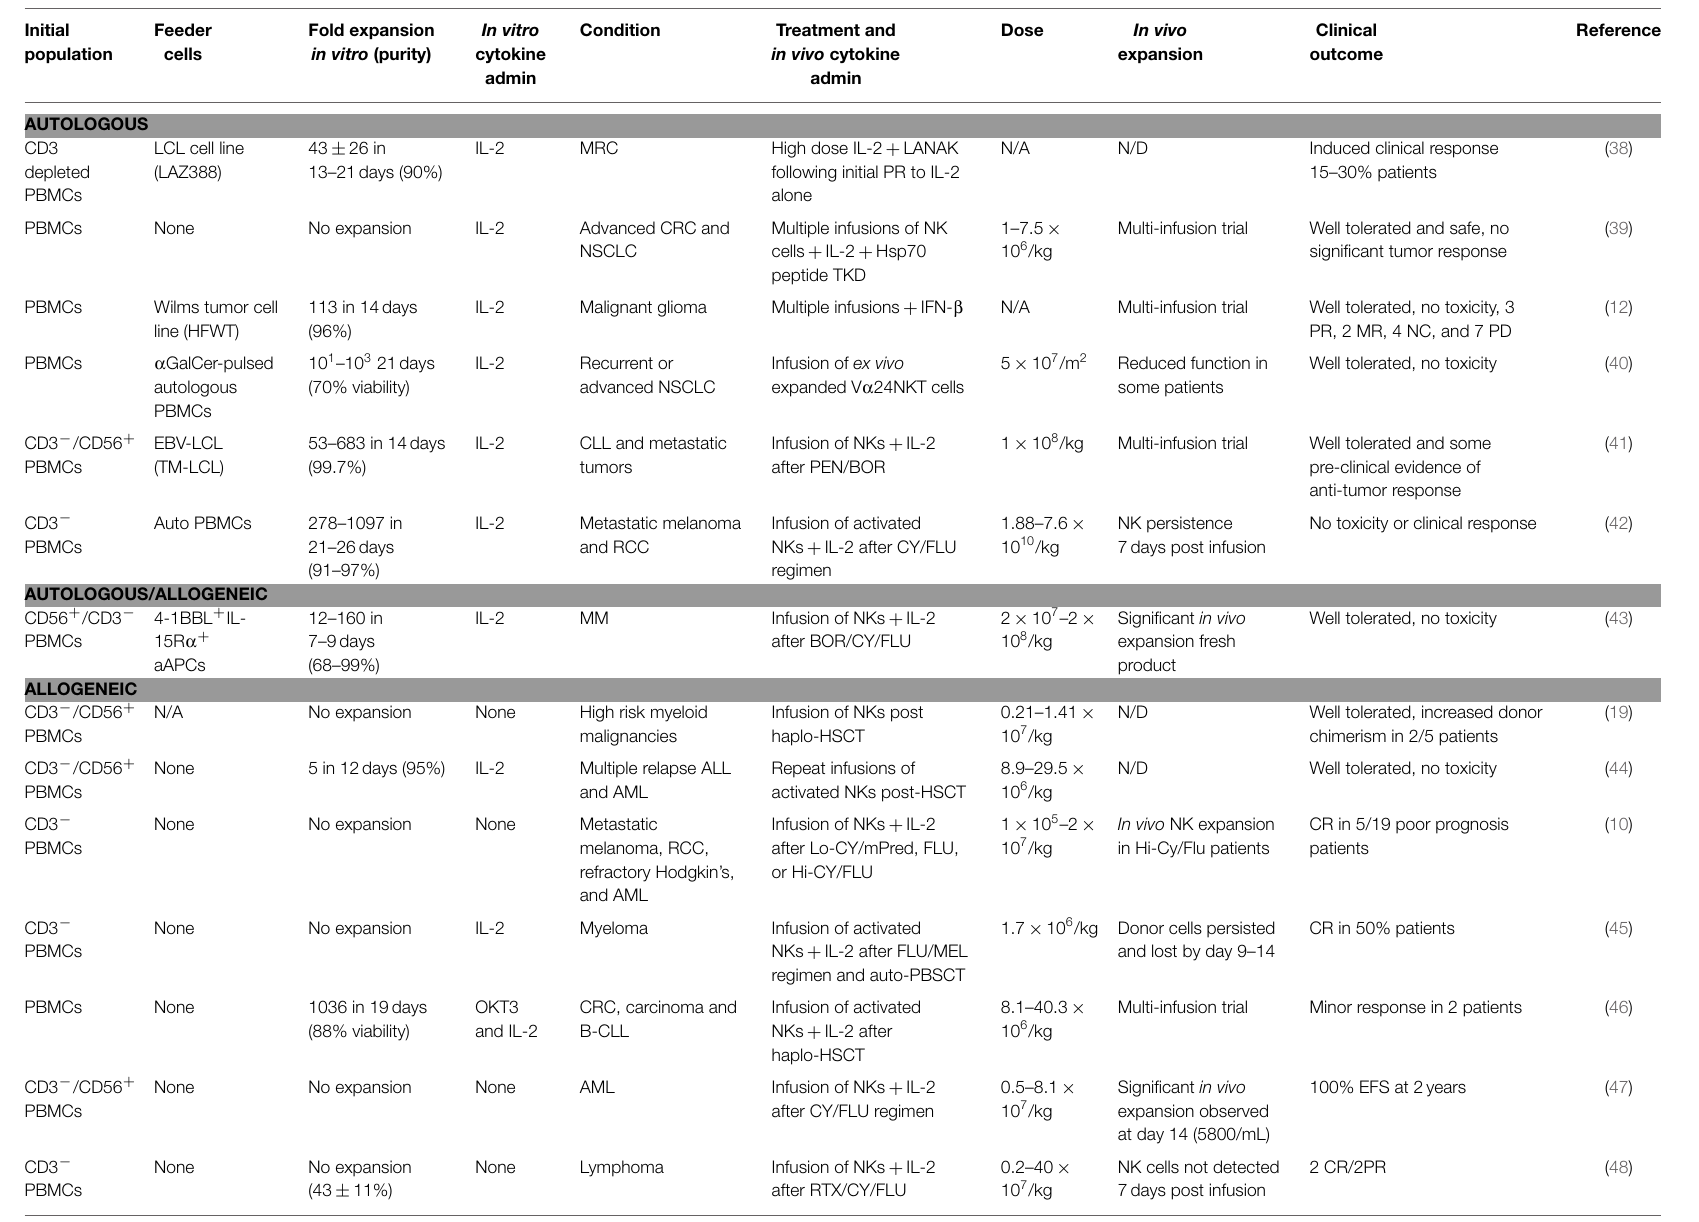
TABLE 1 | NK cells in the clinic: trials so far